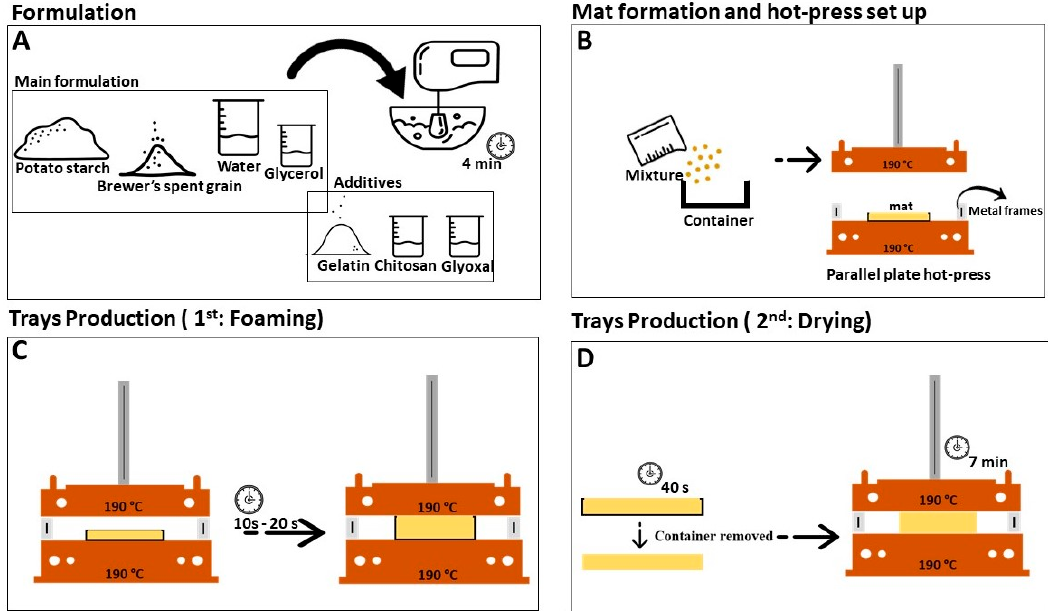
Figure 1. Schematic representation of the trays’ production steps.